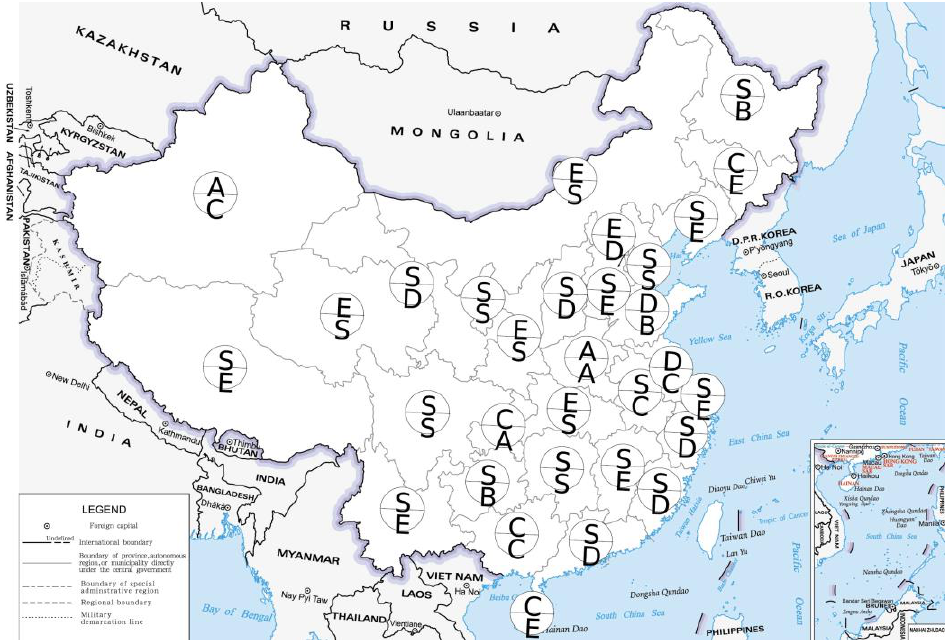
Figure 5. Ranks of domestic pollution effectiveness. (Note: the map was made based on the GS (2019) 1679, available online: http://bzdt.ch.mnr.gov.cn, accessed on 17 February 2023). 1679, available online: http://bzdt.ch.mnr.gov.cn, accessed on 17 February